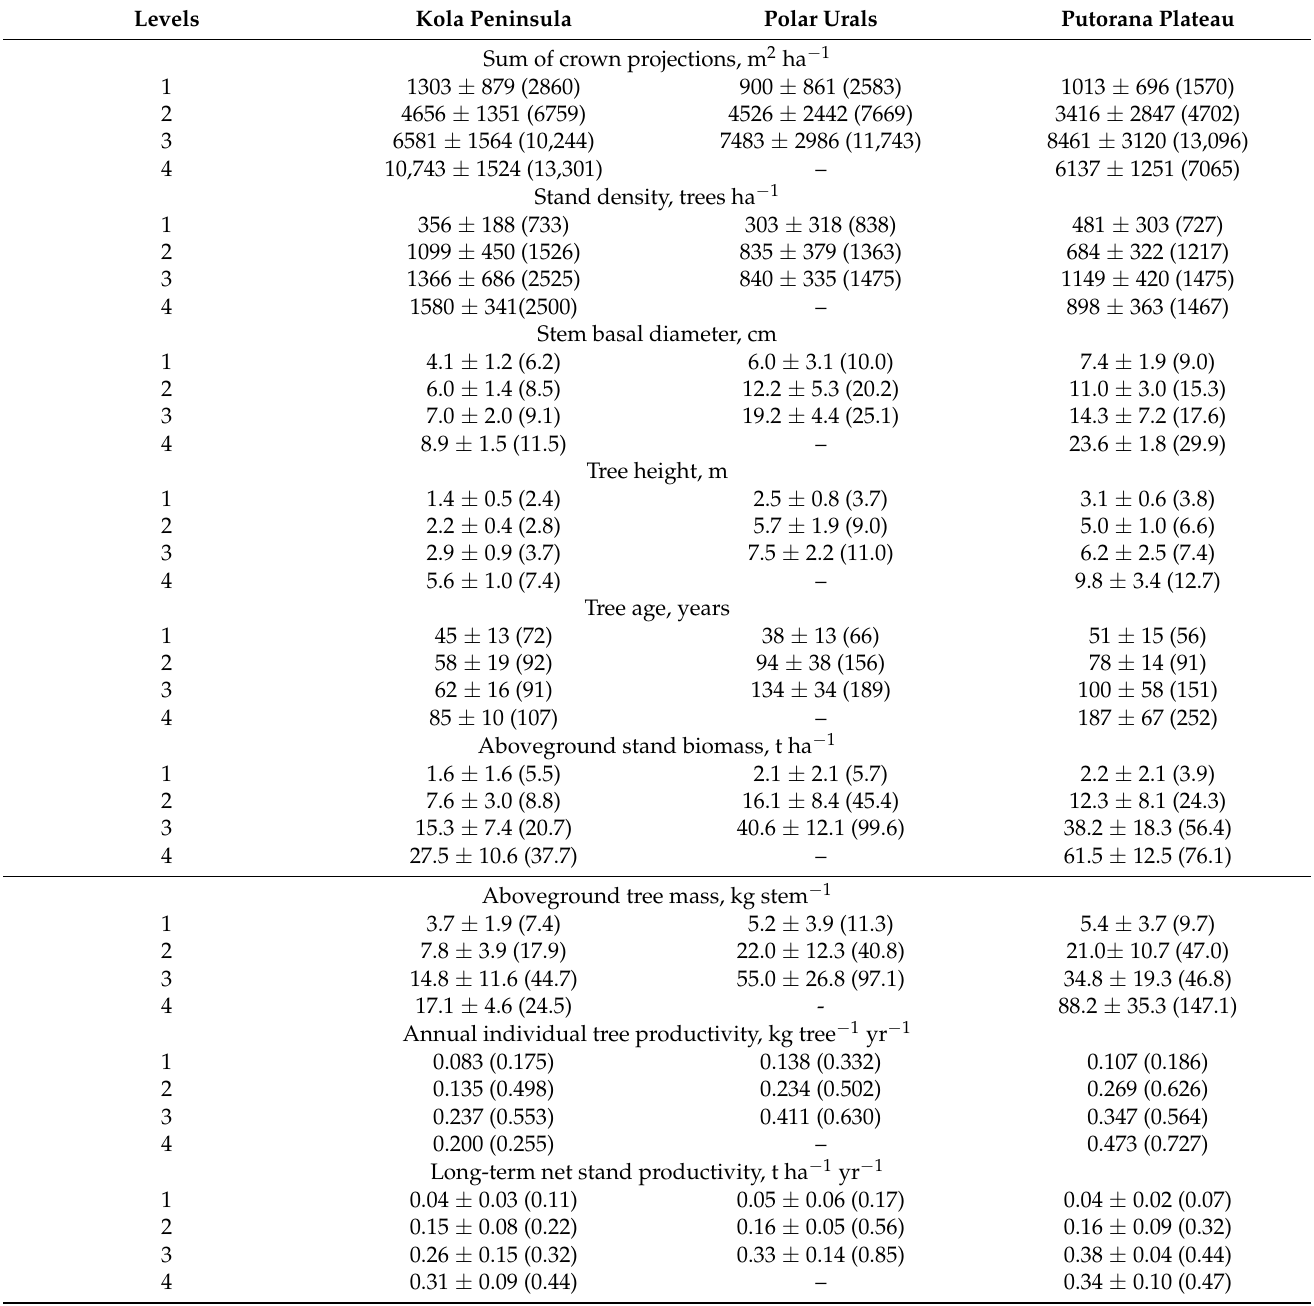
Table 4. Stand parameters (mean ± SD (max)) on different altitudinal levels in forest–tundra transition in subarctic regions of